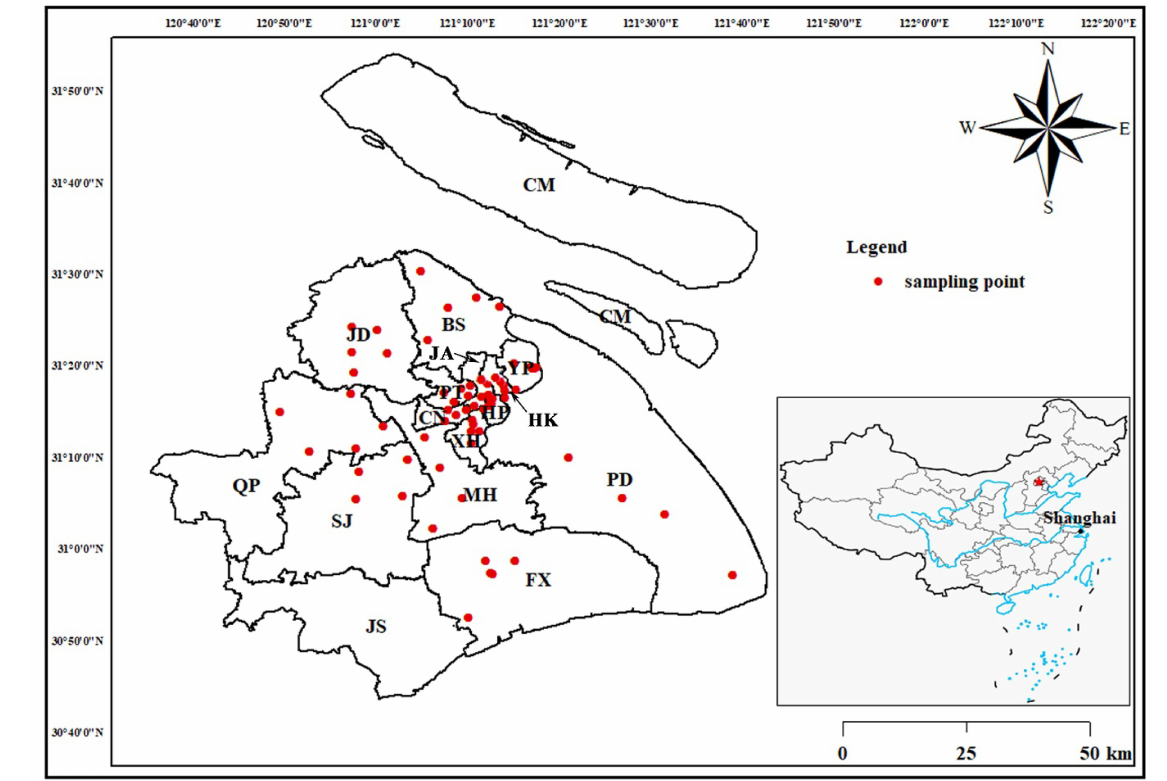
Figure 1. Distribution of sampling points in